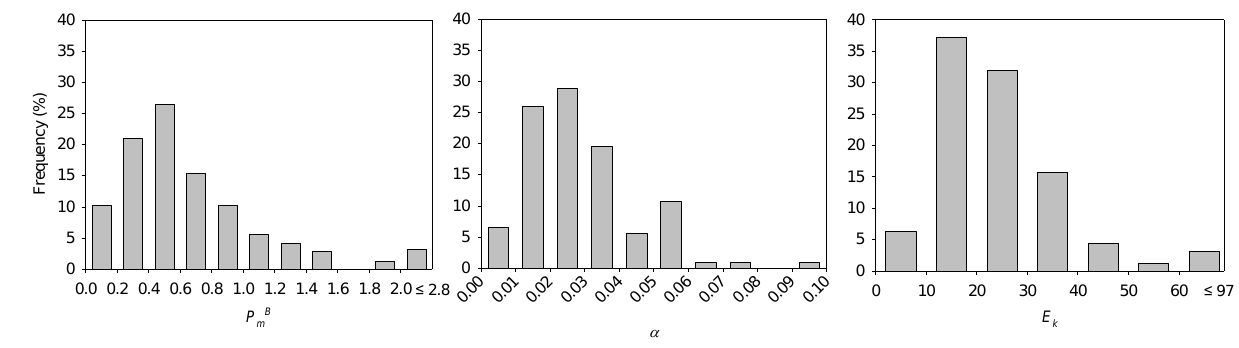
Fig. 4. Relative frequency distribution of photosynthesis-irradiance parameters at the SCM.